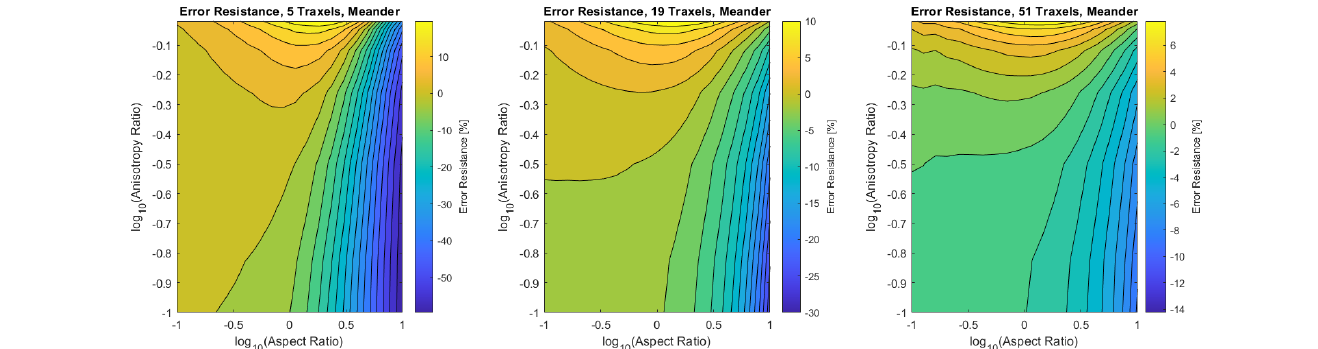
Figure 18. A close-up of the data in Figure 16 for anisotropy ratios close to 1.